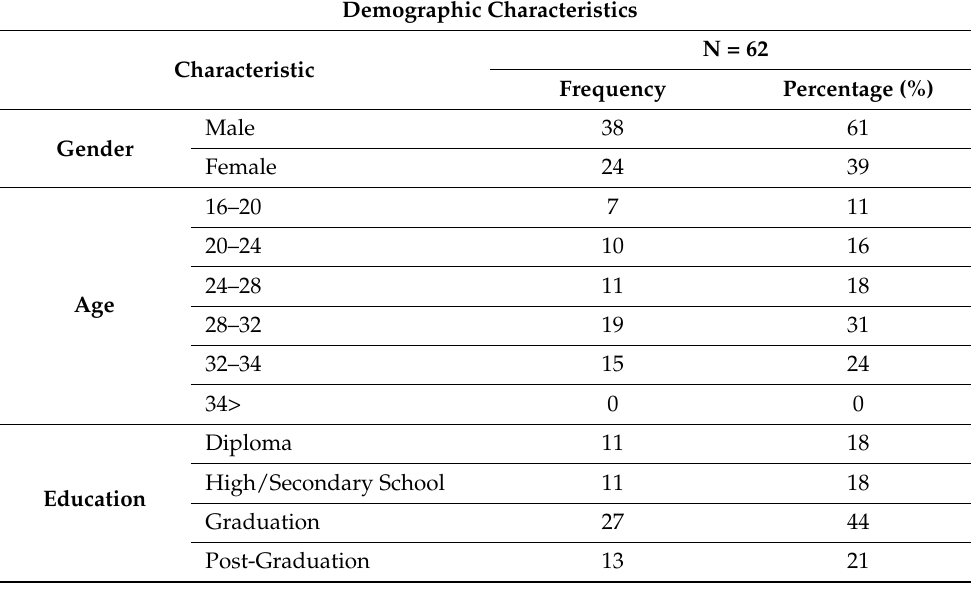
Table 3. Demographic characteristics of the participants.